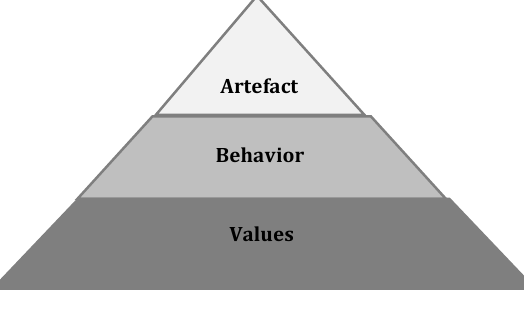
Fig. 1 Element of Culture